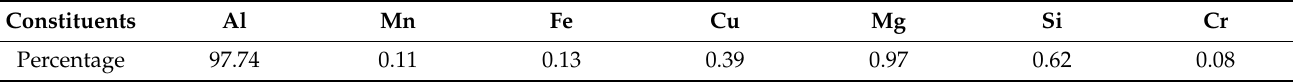
Table 1. Elemental analysis of Al